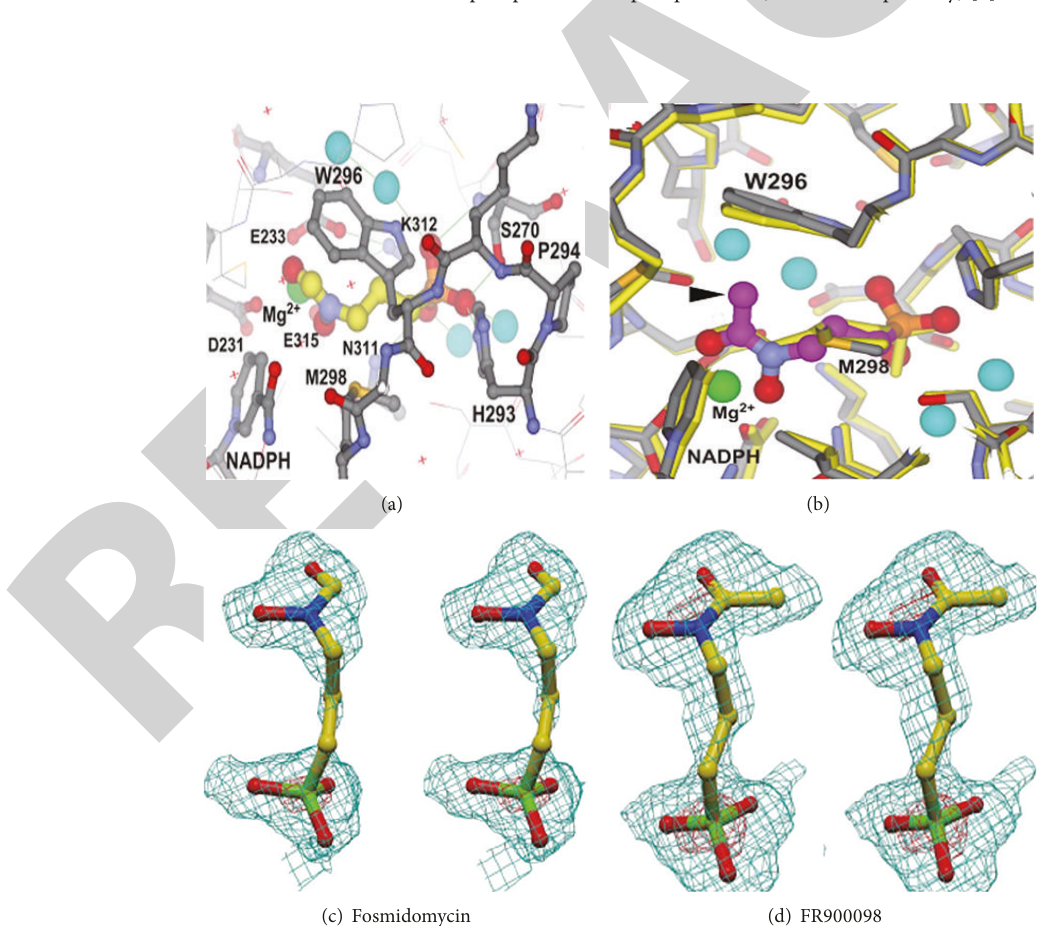
Figure 4: (a) Interaction of fosmidomycin with Pf DXR. FR900098 complex. (b) The carbon atoms of the FR900098 molecule are shown in magenta, (c) fosmidomycin, and (d)